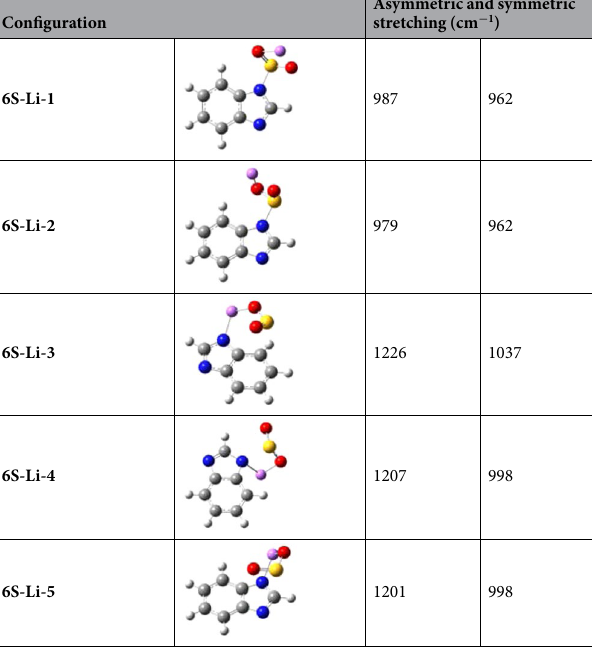
Table 1. Vibration frequencies of S-O bonds in stable configurations of 6-cation-SO 2 .